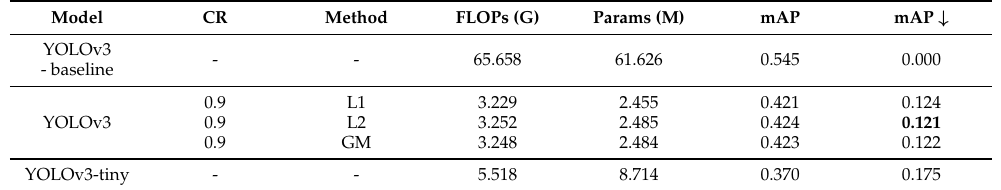
Table 4. Comparison of YOLOv3 on Pascal VOC. “mAP ↓ ” is mAP drop from baseline model, with smaller values being better; “CR” and “Method” have the same meaning as in Table